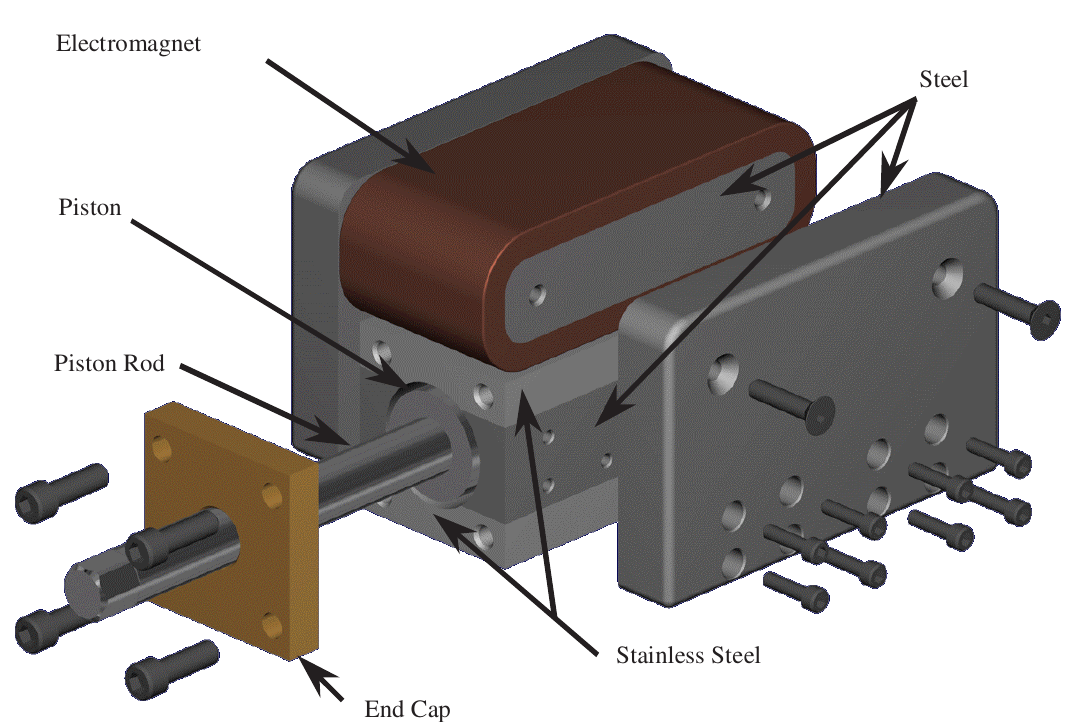
Fig. 3. Magneto rheological (MR) damper design